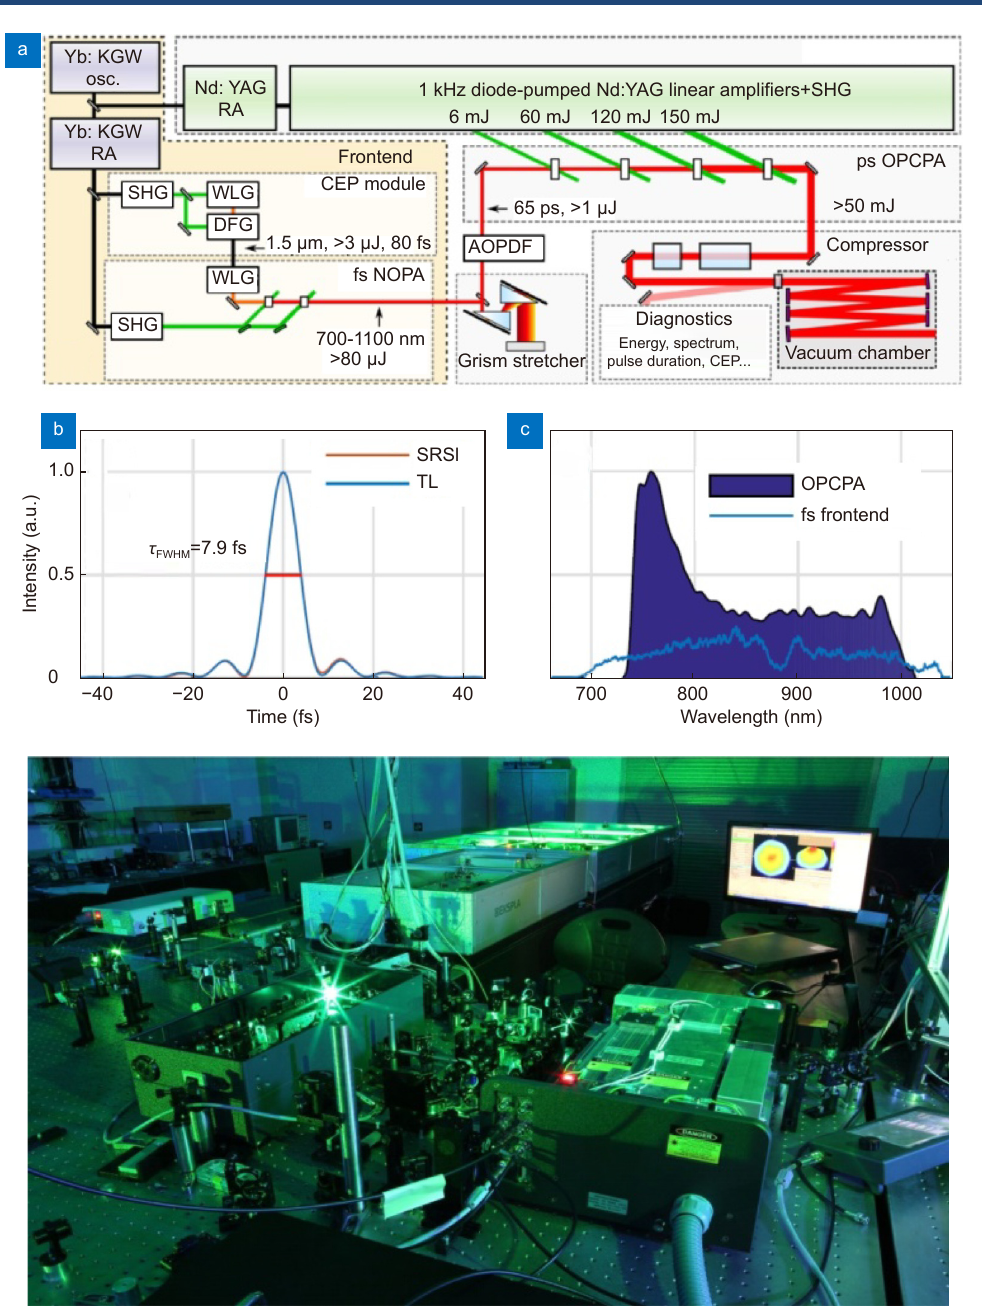
Fig. 3 | ( a ) Layout of multi-terawatt high average power NIR OPCPA system with complex Yb:KGW laser-based front-end, which includes super- continuum generation, DFG and complimentary noncollinear OPA. ( b ) Compressed pulse envelope measured with a self-referenced spectral in- terferometry (SRSI) and theoretical transform-limited pulse envelope (TL). ( c ) Comparison of seed and amplified pulse spectra. Photo at the bot- tom: laboratory view of a running system. Image courtesy dr. A. Varanavičius, Laser Research Center, Vilnius University. Figure reproduced with permission from: (a–c) ref. 88 , The Optical